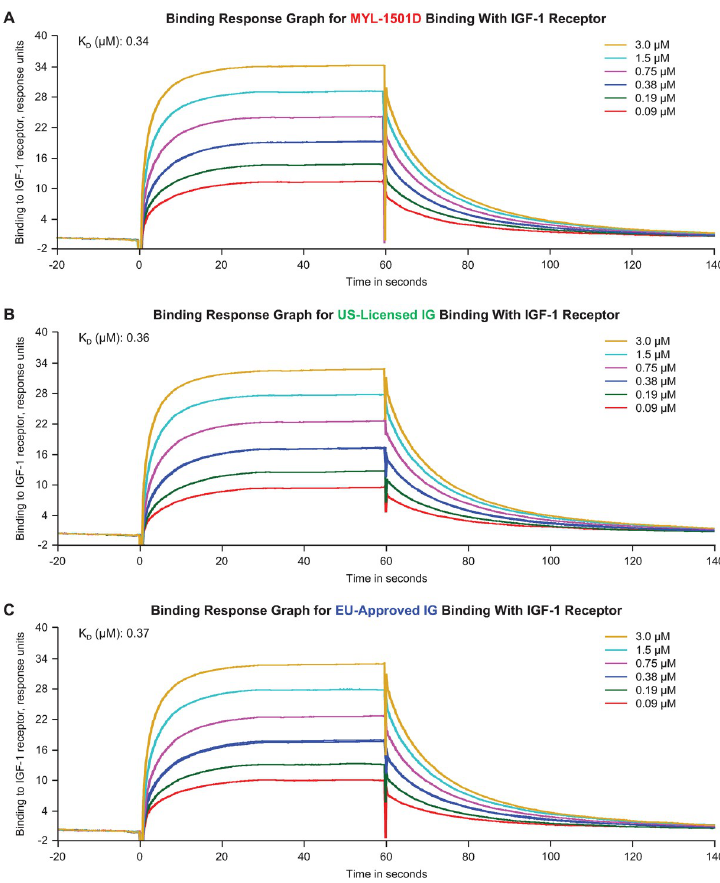
Fig 8. Representative binding response graph of insulin-like growth factor receptor-1 binding kinetics assay. (A) MYL-1501D, (B) US-Licensed Insulin Glargine, and (C) EU-Licensed Insulin Glargine. Each lot was analyzed over 6 concentrations, and kinetic parameters were evaluated by 1:1 interaction model using global fit. Each lot was analyzed 3 independent times, and mean K D value was reported. K D , equilibrium dissociation constant.